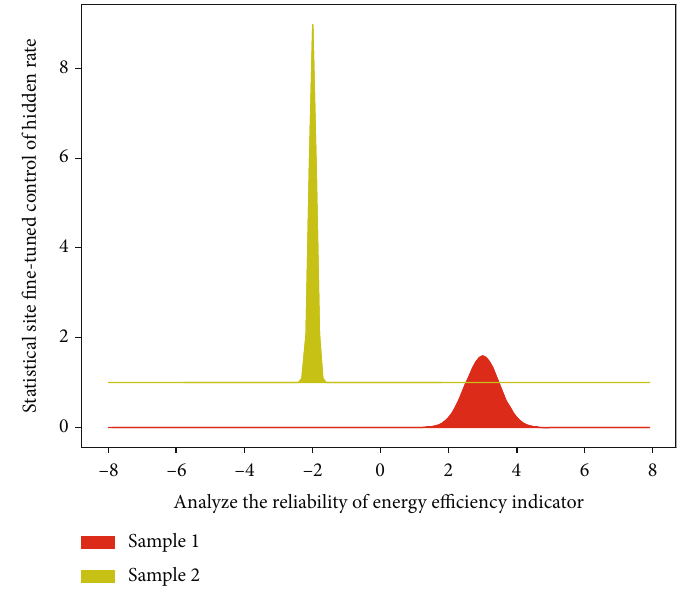
Figure 3: Analysis of fi ne control energy e ffi ciency reliability.